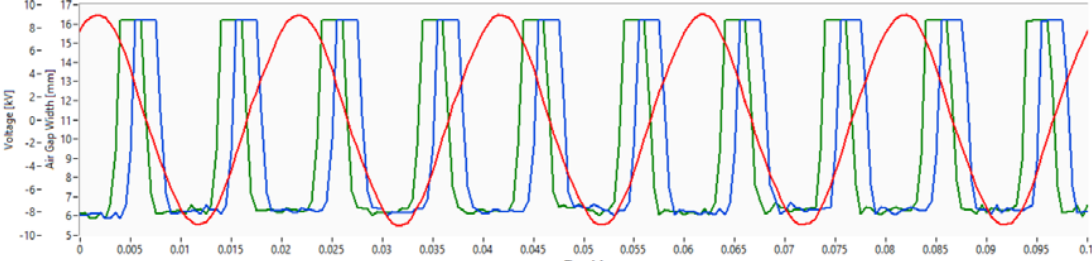
Figure 7. Relation of terminal voltage signal and air gap signal as load angle changes. The red curve represents the generator terminal voltage signal, the blue curve represents the air gap sensor signal when the generator is in the no-load operation mode and the green curve represents the air gap sensor signal when the generator is loaded.